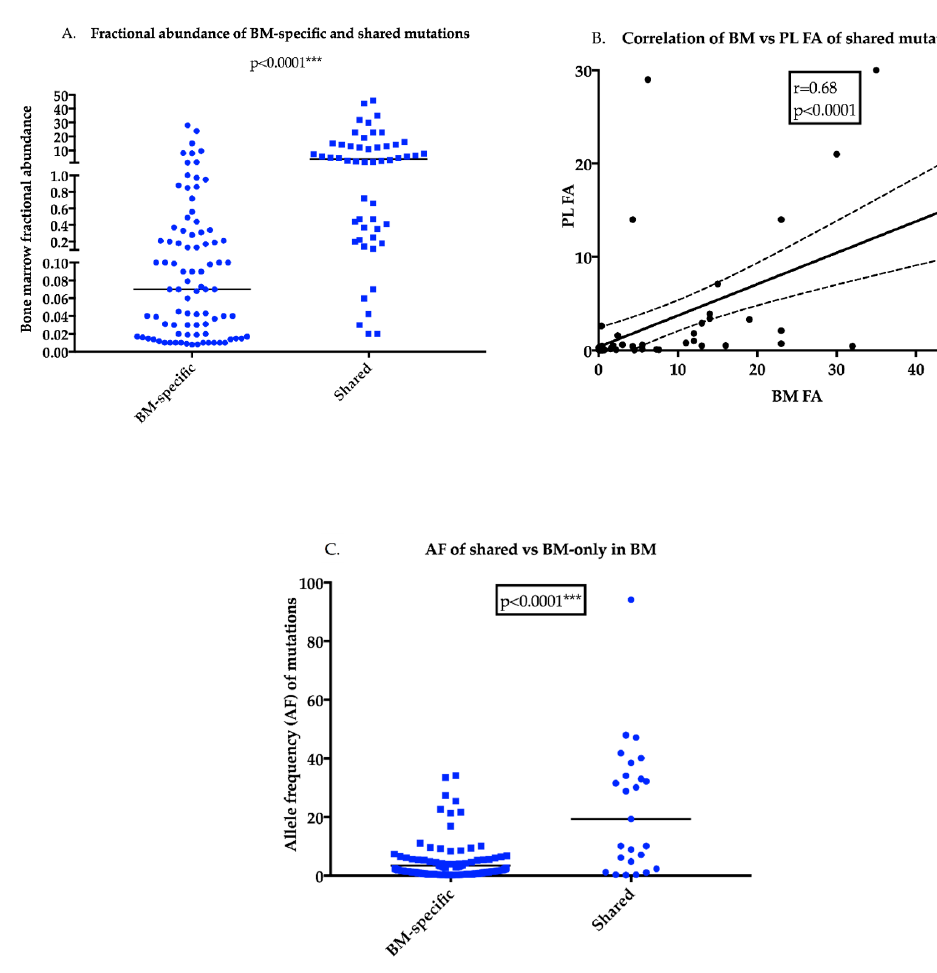
Figure 3. Dominant mutations in the BM have a higher likelihood of presence in PL ( A ) BM FA levels for two kinds of mutations (i) specific to the BM compartment versus (ii) present in both BM and PL compartments utilising a scatter dot-plot. Median FA levels are indicated by the black line derived from the OMD analyses. The median FA of shared mutations is significantly higher than FA of mutations detected in the BM alone (Mann Whitney t -test, *** p < 0.0001). ( B ) Correlation plot of BM AF and PL AF of shared mutations detected by OMD analyses indicates a moderate to strong association of BM AF with AF in the PL ( p < 0.0001) ( C ) Scatter dot-plot with median levels represents a comparison of the AF of shared mutations and BM-only mutations derived from 36 matched BM and PL from MM patients utilising TAS. Results of the OMD were recapitulated in TAS indicating that shared mutations have a significantly higher BM AF (Mann Whitney t -test, *** p < 0.0001).(PL: